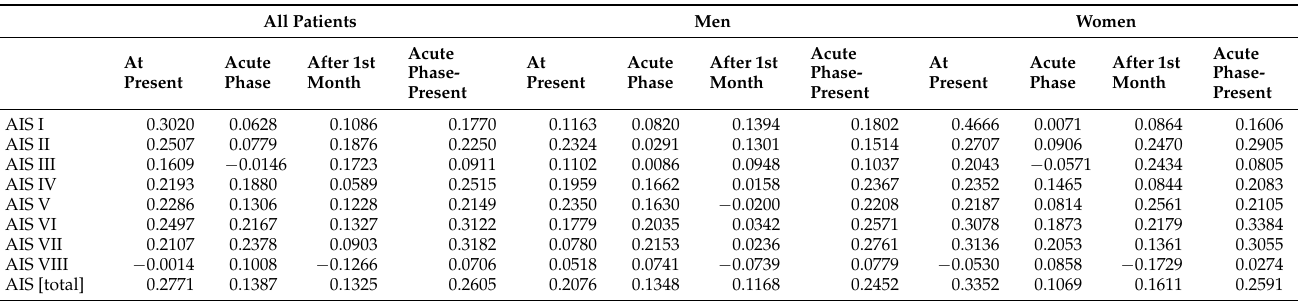
Table 6. Correlation of the results obtained in the AIS with the number of symptoms related to COVID-19 by gender (Spearman’s rank-order).